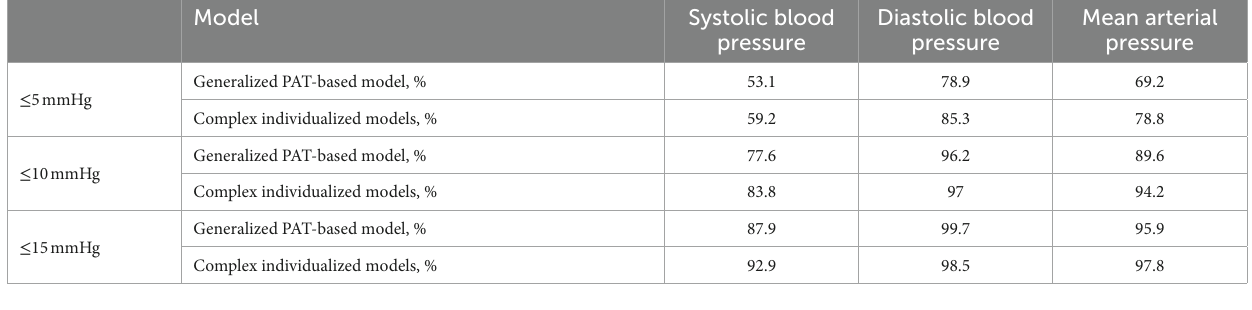
TABLE 4 Percentage of absolute errors within 15, 10, and 5